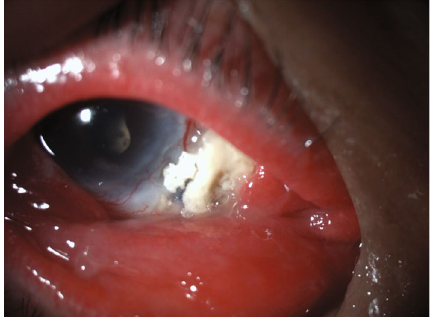
Figure 2: Slit-lamp photograph of the right eye of case 2 showed severe congestion of temporal conjunctival vessels, mucopurulent discharge, and necrotic scleral ulcer in the area of previous pterygium excision.